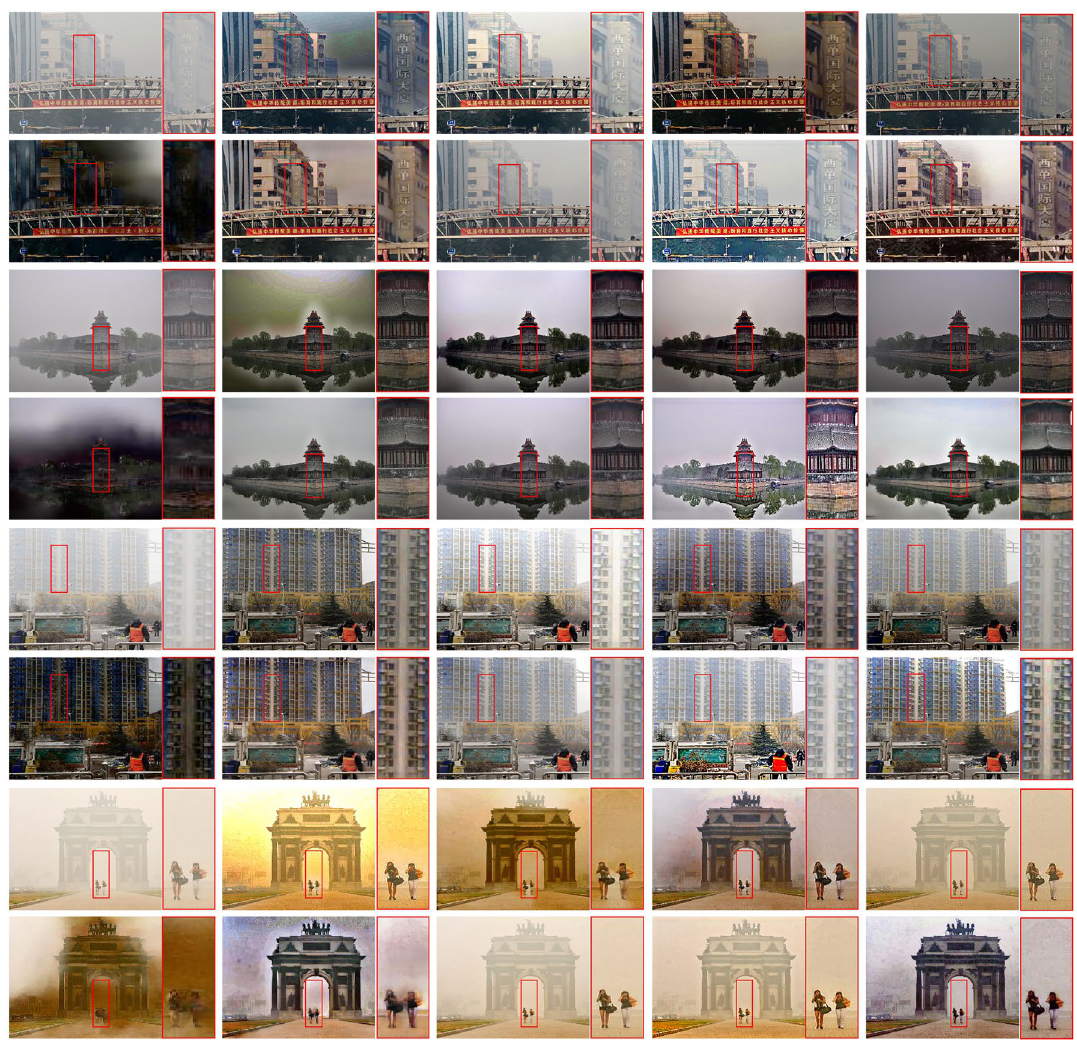
Figure 9. Results of comparison experiments on the URHI datasets. The content in the red box in the image is enlarged for visual comparison. From left to right and top to bottom: Input hazy images, dehazed images using